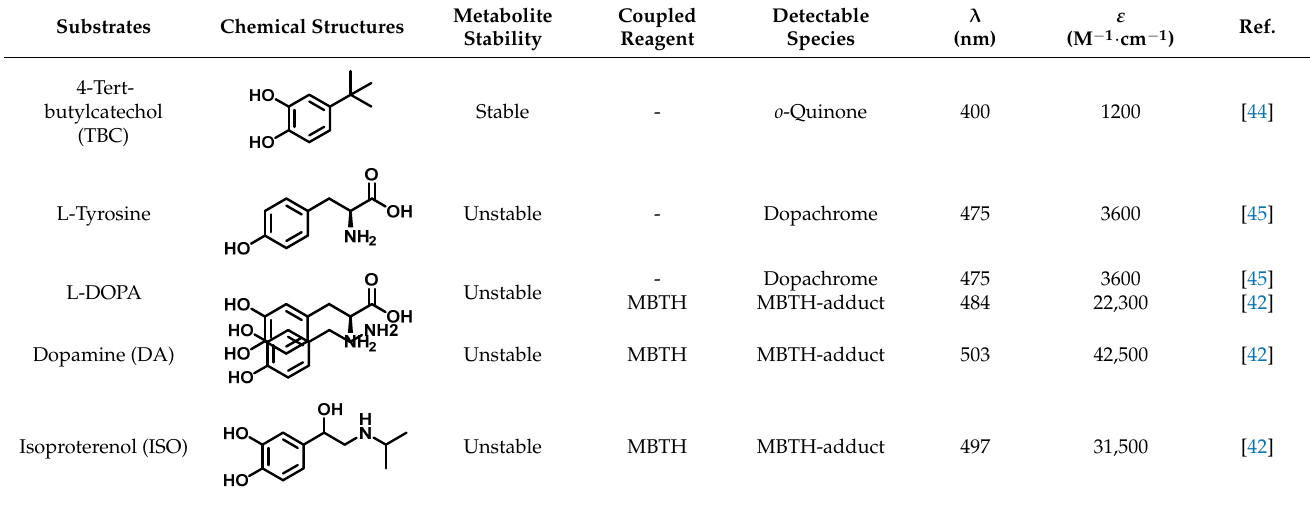
Table 1. Properties of the detectable species from several substrates.